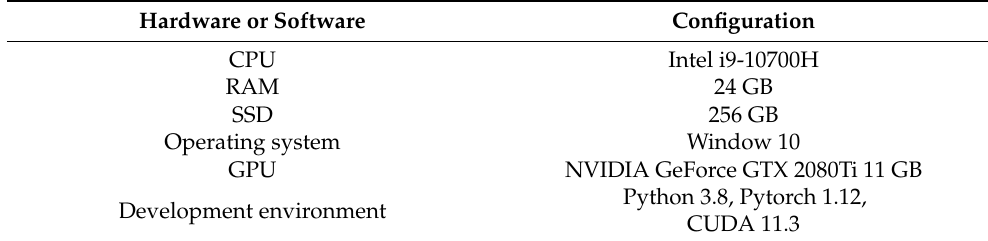
Table 2. Hardware and software configuration.